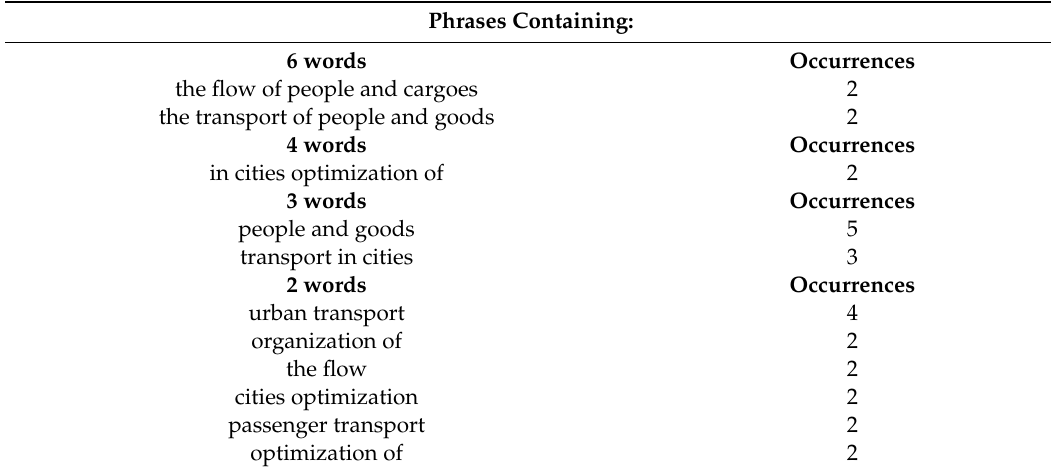
Table A3. Text mining results (Q1).